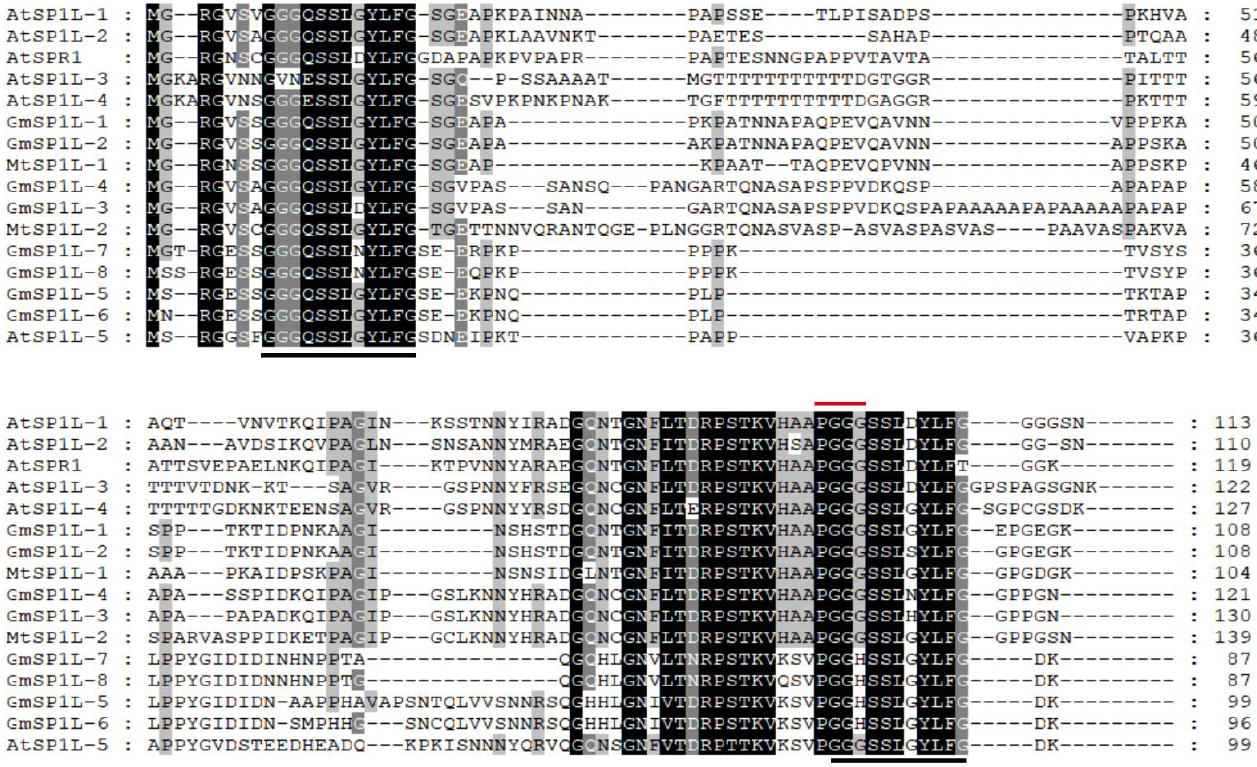
Figure 2. Protein sequences alignment. The identical amino acid residues among all proteins are shown in black boxes, and the conserved residues are shown in gray boxes. The two solid lines under the sequences mark the locations of a direct repeat sequence. The predicted MT binding motifs (GGG and PGGG) are marked with red lines.